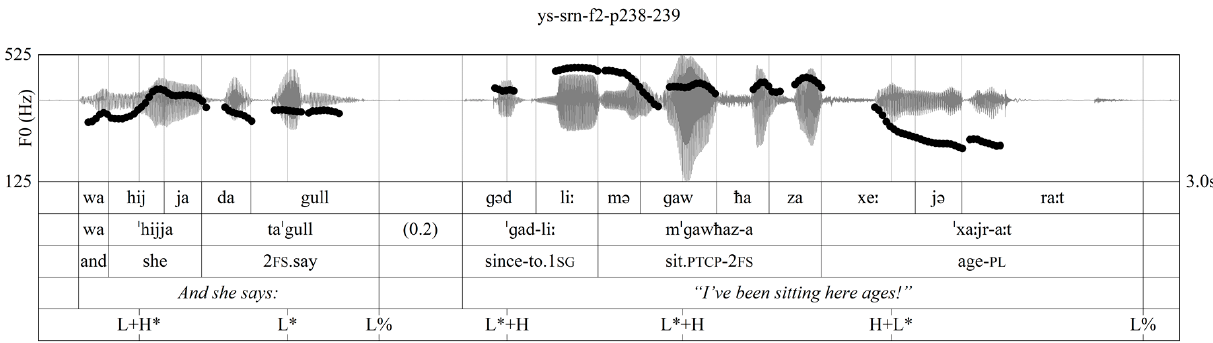
Figure 4. Sequence of turns (W then A) with narrow versus wide pitch span (0.5 versus 1.3